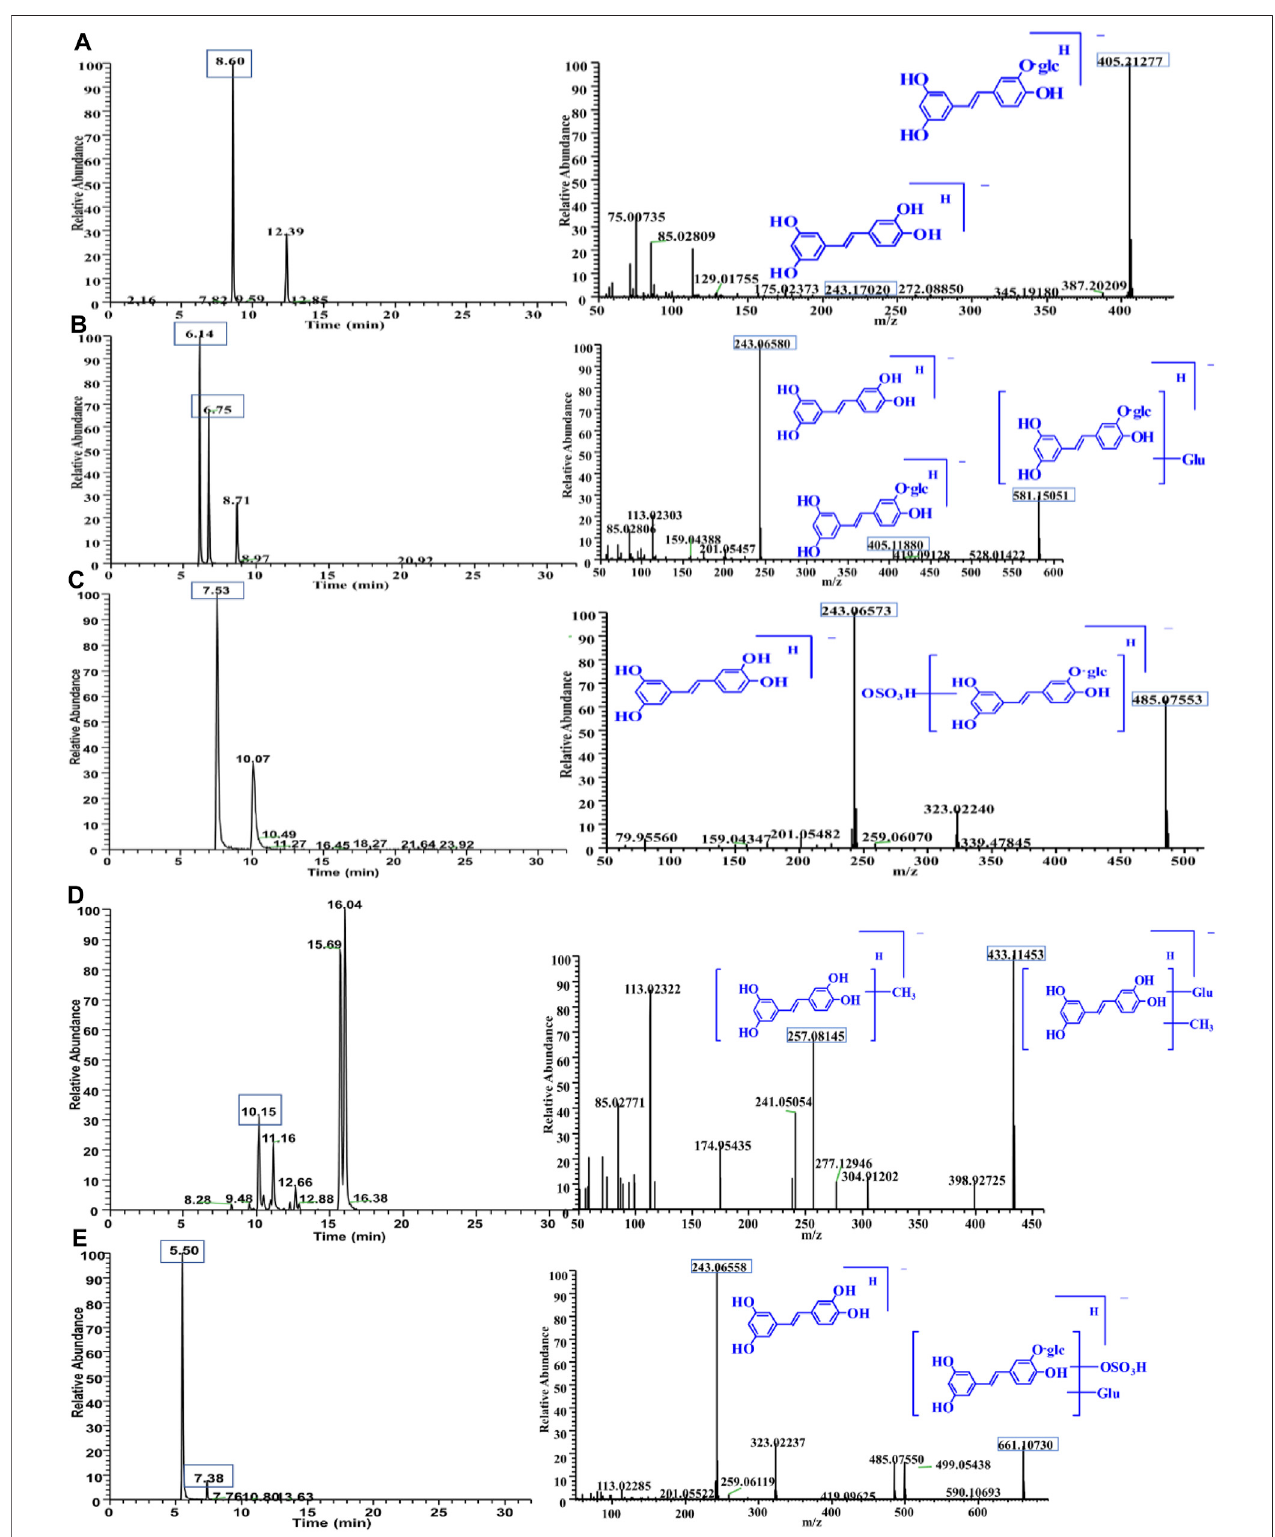
FIGURE4| ChromatogramandMS/MSspectraofmetabolitesofPG invivo (A) :M0=405.11838; (B) M1=581.15051; (C) M2=485.07553).Chromatogramand MS/MS spectra of metabolites of PG in vivo (D) : M3 = 433.11453; (E) : M4 = 661.10730).